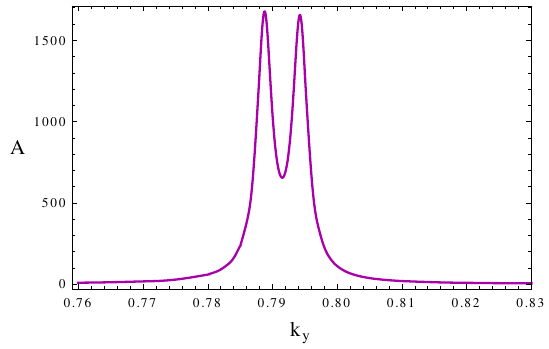
Figure 6 . The spectral density A as a function of k y at the (cid:12)rst Brillouin zone boundary k x = 1 for q = 2 ; ! = 10 (cid:0) 6 . There are two pronounced peaks near k y = 0 : 79 indicative of two separate Fermi surface branches. The background geometry is that of (cid:12)gure 1 with T = 0 : 01426 and k =